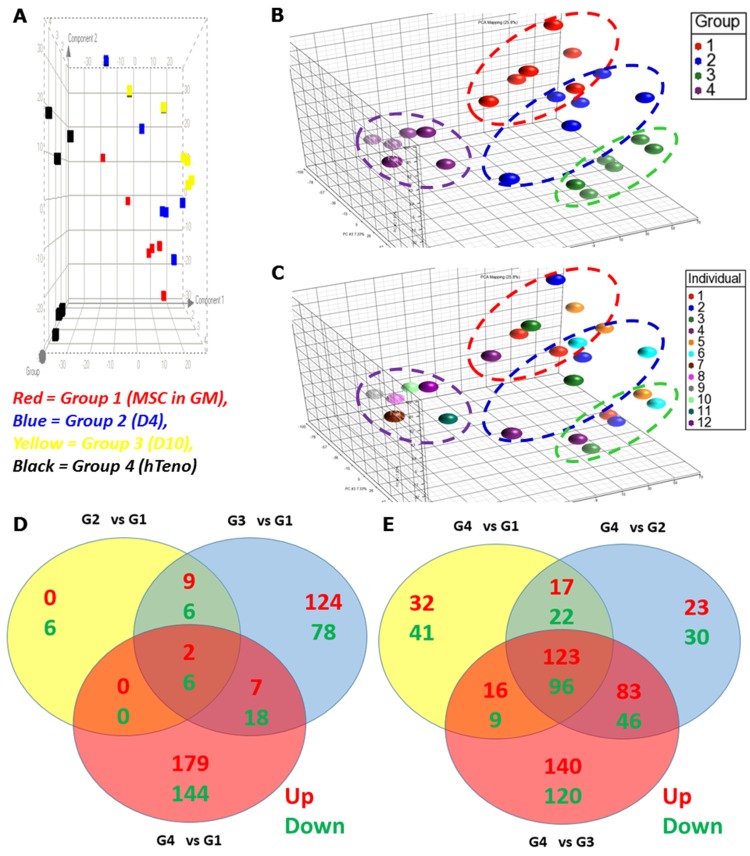
Overview of microarray analysis: principle component analysis (PCA) and Limma analysis.PCA analysis was performed on all samples and all probes to characterize the variability present in the data. The results showed a distinct separation between all the groups. The PCA was visualized in 2D view (A) and 3D view (B), with the different colour coded for different groups; and the 3D view (C) with the colour coded for different individual donor (In the legend, individual 1 to 6 were the bone marrow donors and individual 7 to 12 were the tendon donors). Image B and C showed that the arrays were grouped according to their experimental groups (treatment) but not according to the donor variation. (Group 1: Control hMSC, Group 2: Day-4 GDF5-induced hMSC, Group 3: Day-10 GDF5-induced hMSC, Group 4: tenocytes). The microarray experiments were designed to detect differential expression of transcripts with GDF5 treatment and were compared with Venn diagrams. The list of the significantly (corrected p-value) up- and down- regulated genes, were used to detect the altered candidate tenogenesis genes within the GDF5-treated groups (Group 2 and 3) as depicted in the intersections or uniqueness; between all comparisons with control hMSC (as depicted in D) and tenocytes compared to all the other groups (as depicted in E). The numbers in each section or intersections of the circles represented the total number of significantly differentially up- or down- regulated genes for the pairwise comparisons (as denoted above or below each circle). The numbers in green and red fonts indicated the significantly up- and down-regulated genes, respectively. (G1: Control hMSC; G2: Day-4 GDF5-induced hMSC; G3: Day-10 GDF5-induced hMSC; G4: tenocytes).